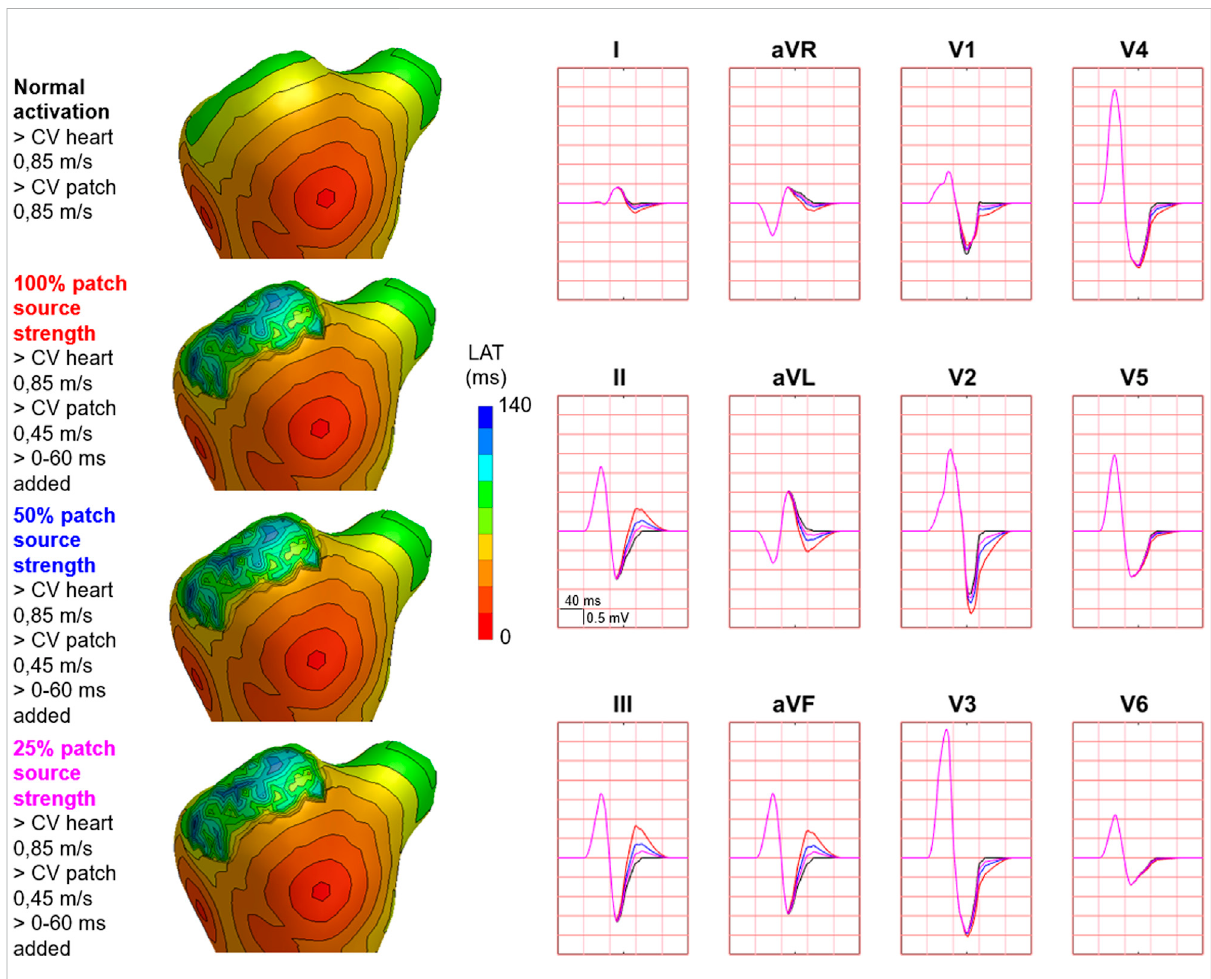
FIGURE 8 Effect of decreasing source strength on body surface potentials. Representative example of the effect of source strength reduction body surface potentials. Activation sequences of the patches and ventricles are displayed from red (early) to blue (late) with isochrone steps of 10 ms. All simulated BSP are displayed in the simulated 12-lead ECG. The colors in the ECG correspond to the colors stated in the left column with the simulation characteristics. With decreasing source strength, the magnitude of effect on the BSP reduced. One cube in the 12-lead ECG corresponds to 40 ms (width) and 0.5 mV